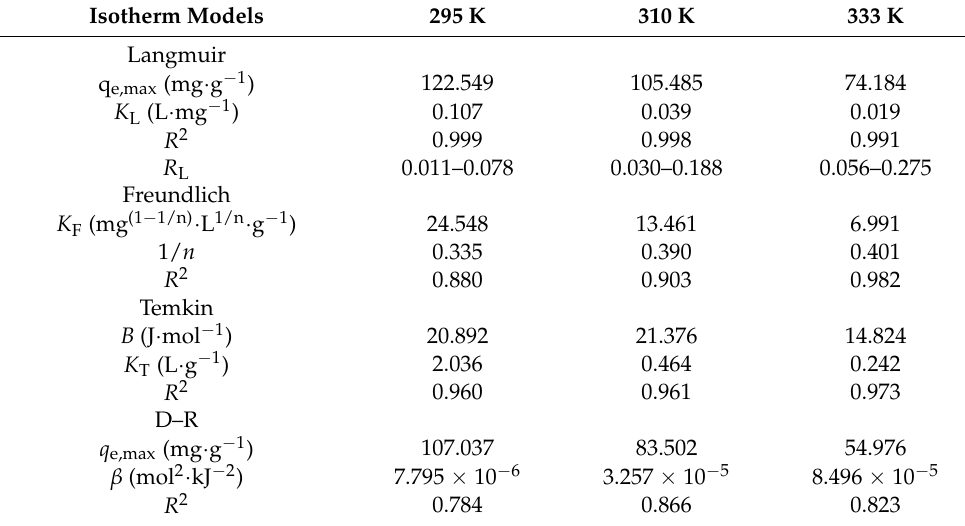
Figure 6. Tests of the ( a ) Langmuir, ( b ) Freundlich, ( c ) Temkin, and ( d ) D–R isotherm models on RBBR adsorption retained by UPA( θ ) powders. at different temperatures. Table 3. Parameters of RBBR adsorption isotherms fitted by the Langmuir, Freundlich, Temkin, and D–R isotherm models at different temperatures.